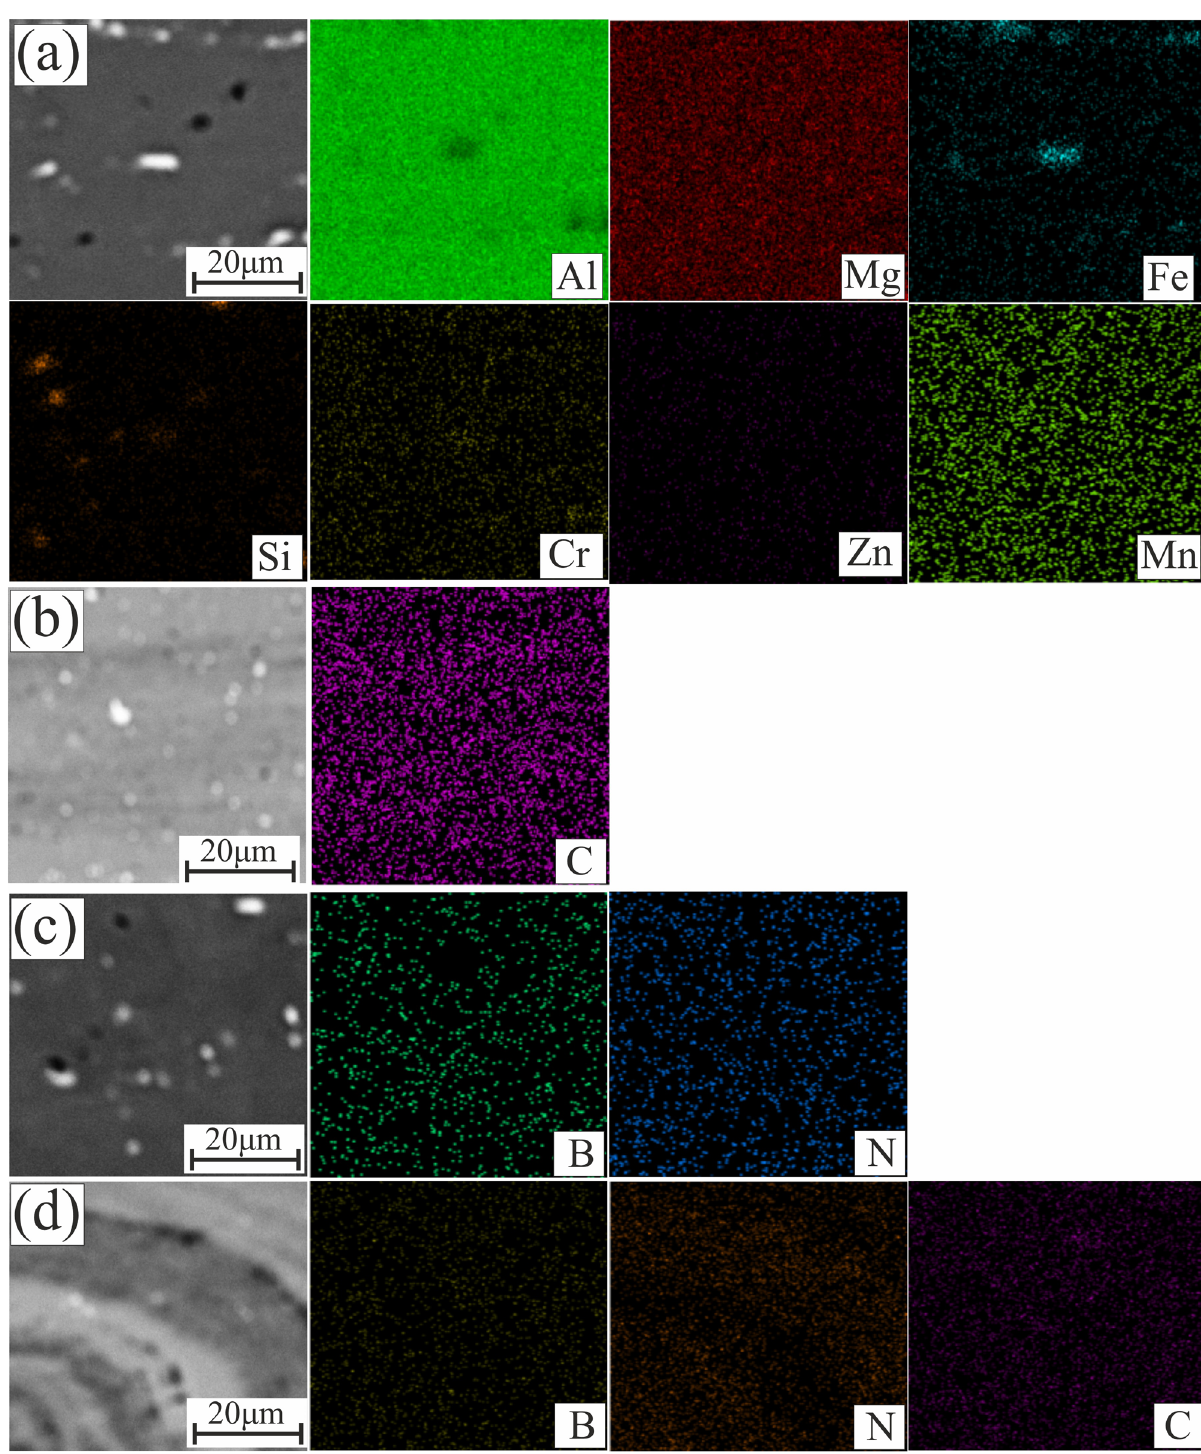
Figure 7: EDS mapping analysis in SZ ( a ) after FSP without reinforcements and reinforced with ( b ) GNPs, ( c ) BN nanoparticles, and ( d ) hybrid of GNPs and BN